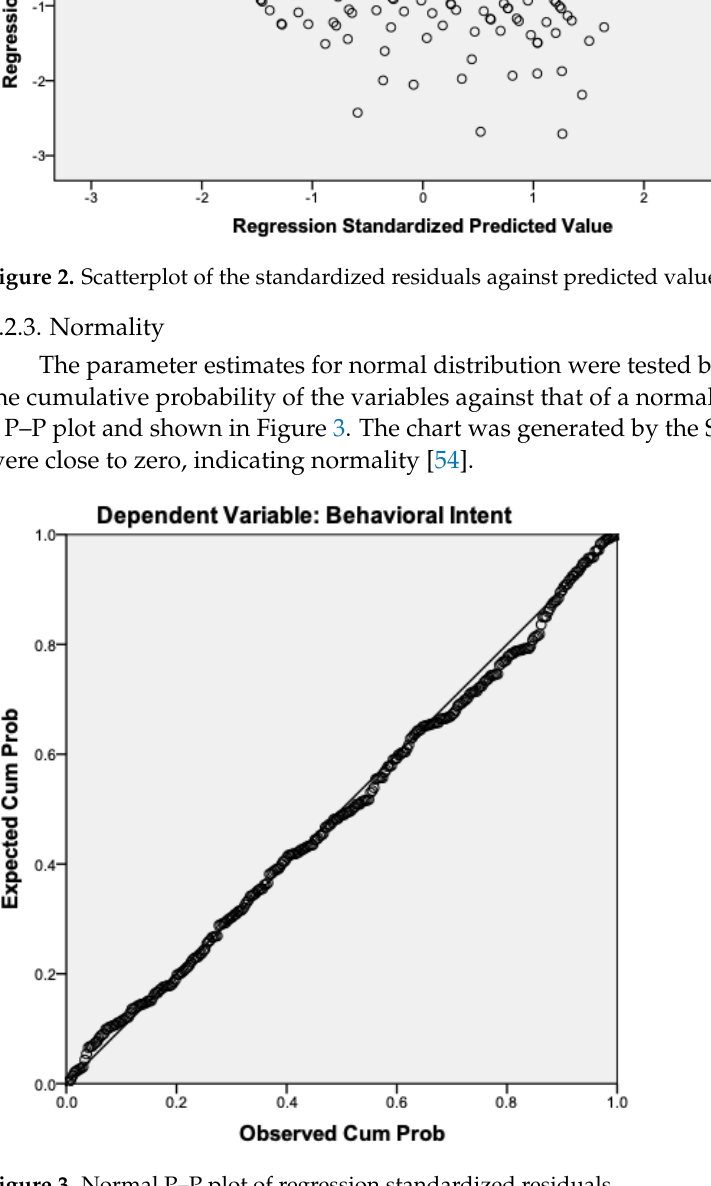
Figure 3. Normal P–P plot of regression standardized